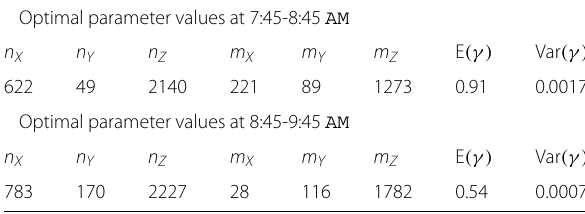
Table 2 Optimal parameter values for Monday - Thursday morning